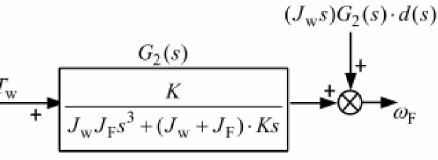
Figure 15. Equivalent transformation of structure diagram of the two-mass wind turbine drivetrain of the generation